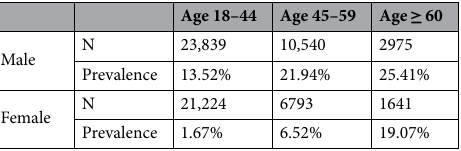
Table 2. Prevalence of MetS in the forthcoming year for different gender and age groups.